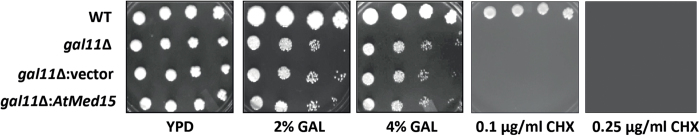
AtMed15 does not complement the function of Gal11 in yeast.Serially diluted equal amount of cells of WT, gal11∆, gal11∆ yeast carrying vector or vector harboring AtMed15 cDNA were spotted on YP agar with galactose as carbon source or YPD agar with cycloheximide (CHX) as xenobiotic as mentioned under each panel. The plates were kept at 30 °C for 3–5 days.